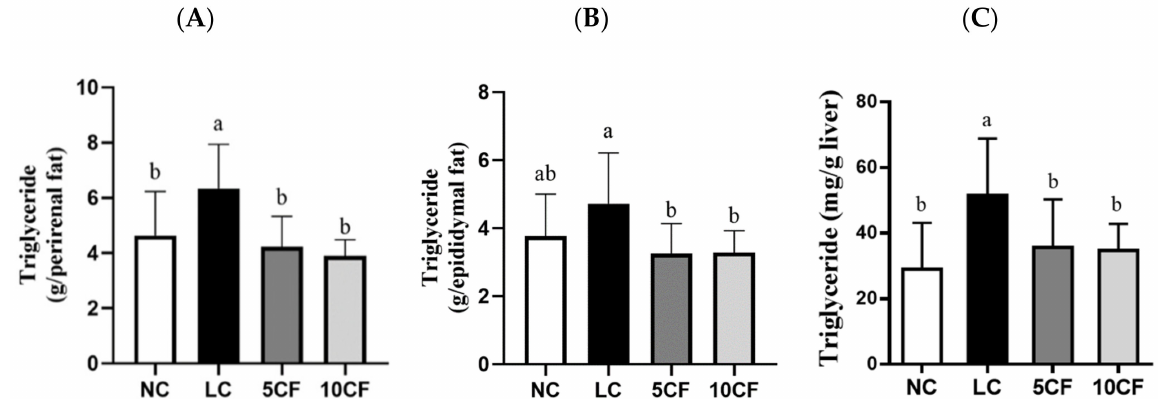
Figure 5. The triglyceride concentration in the perirenal and epididymal adipose tissue and in the liver of rats fed with different experimental diets for 11 weeks. The levels of triglycerides in ( A ) perirenal adipose, ( B ) epididymal adipose, and ( C ) liver were measured. Results are expressed as the mean ± SD for each group ( n = 8). Values with different letters were significantly different, p <